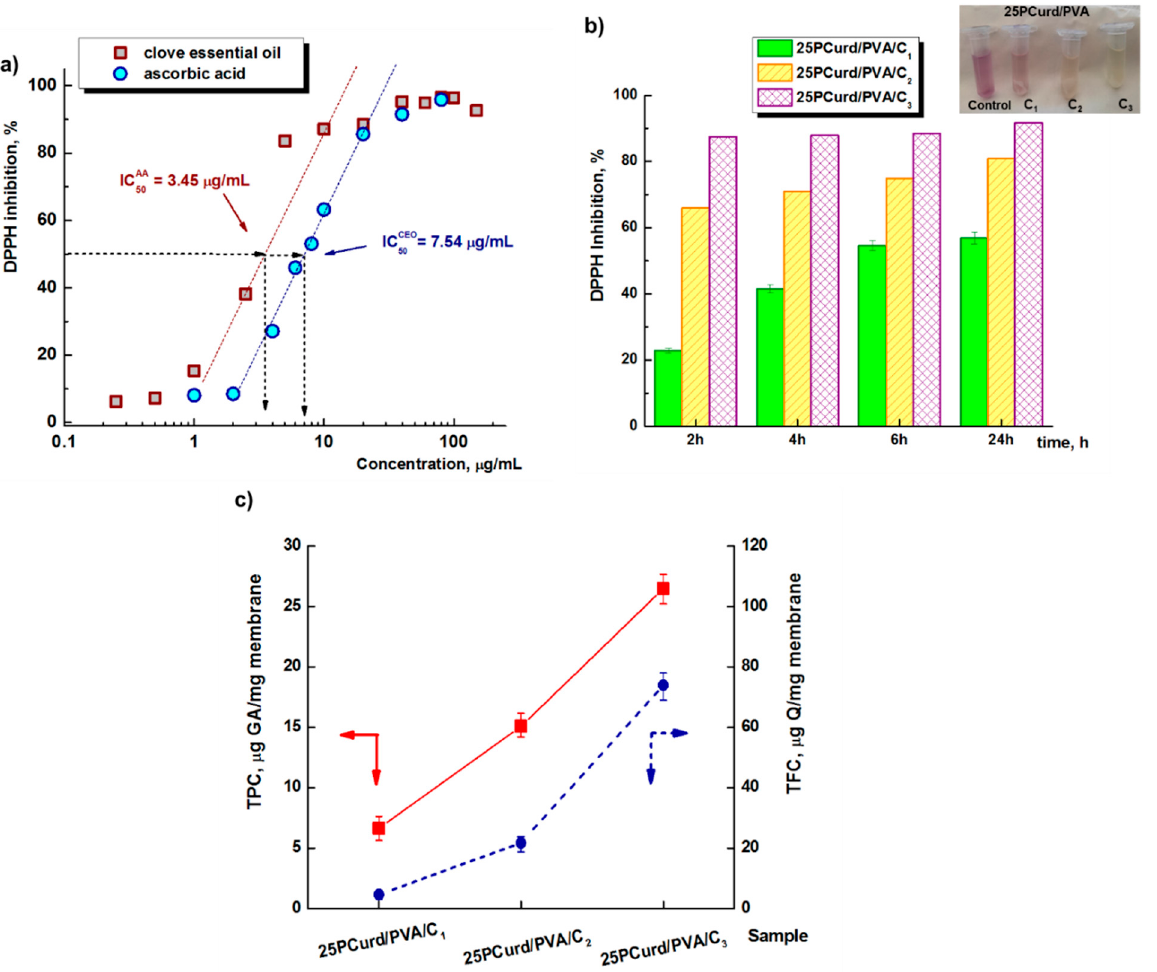
Figure 6. DPPH free-radical scavenging activity at different concentrations of CEO and ascorbic acid as reference ( a ), the CEO-loaded 25PCurd/PVA electrospun membrane ( b ), and the total phenolic content (TPC) and total flavonoid content (TFC) from CEO-loaded 25PCurd/PVA electrospun membrane ( c ).